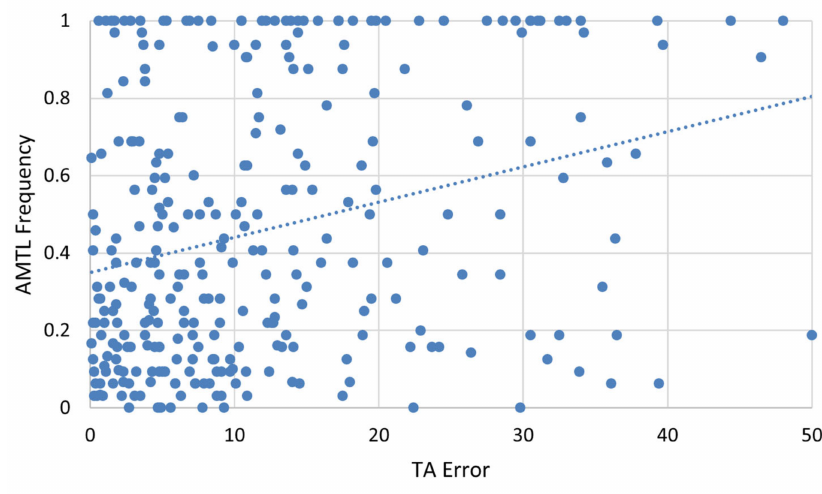
Figure 9. Association between AMTL frequency and TA error (not controlling for age).